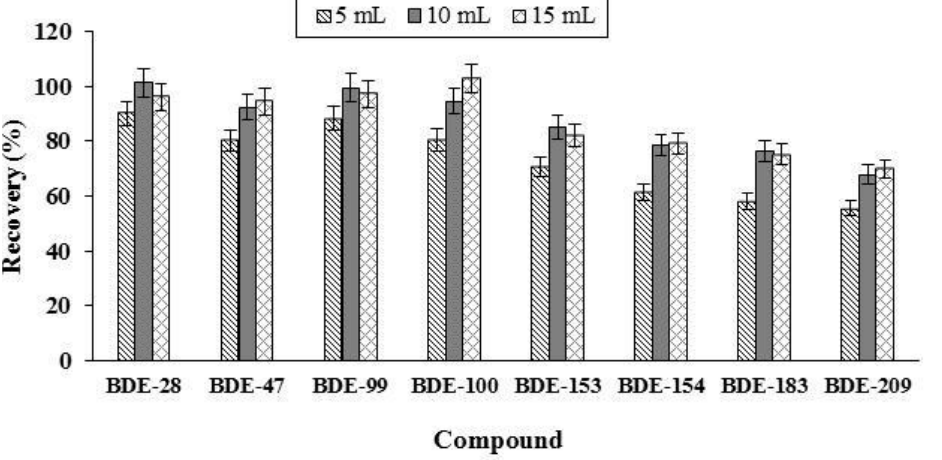
Figure 4. Effect of dichloromethane/n-hexane (50:50, v / v ) volumes on extraction recoveries of eight PBDEs ( n = 3).